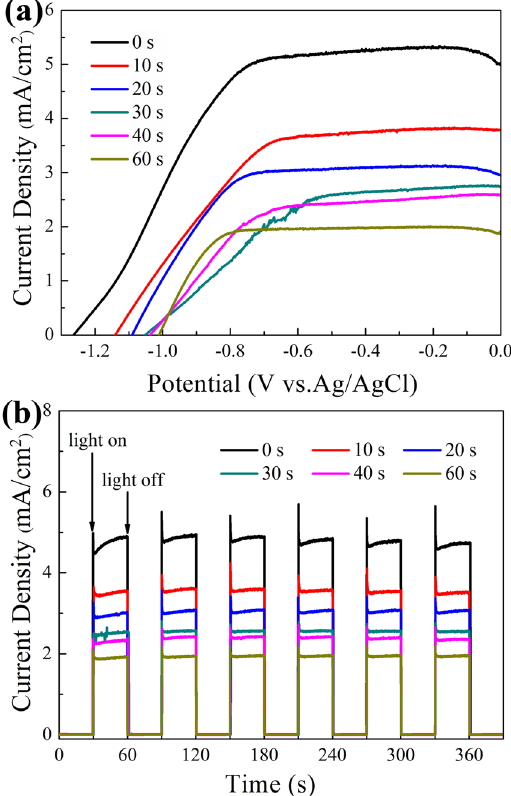
Figure 7. ( a ) Photocurrent density versus potential characteristics of the TiO 2 NRAs/CdS/Au, ( b ) Photocurrent density versus time characteristics of the TiO 2 NRAs/CdS/Au under 0 V versus Ag/AgCl bias.